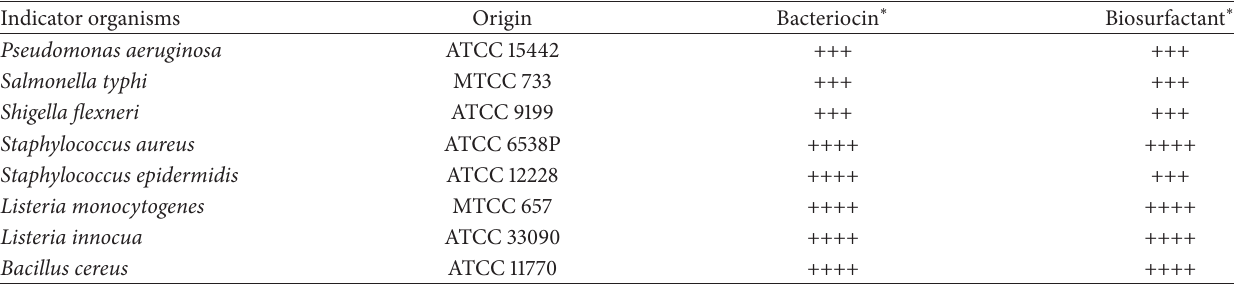
Table 4: Antibacterial activity shown by bacteriocin and biosurfactant against various test organisms. Indicator organisms Origin Bacteriocin ∗ Biosurfactant